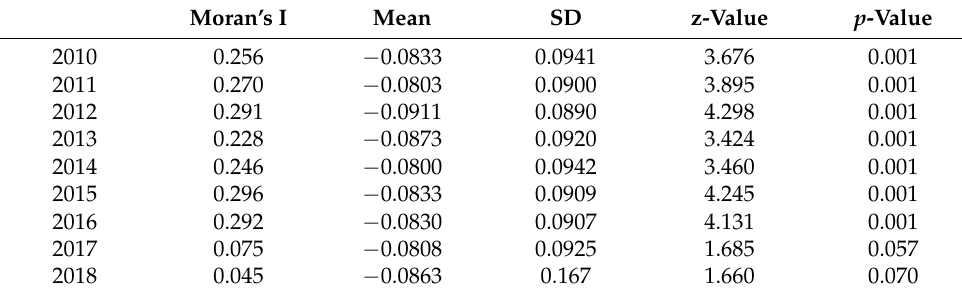
Table 3. Global Moran’s I result of the Aba disaster resilience.